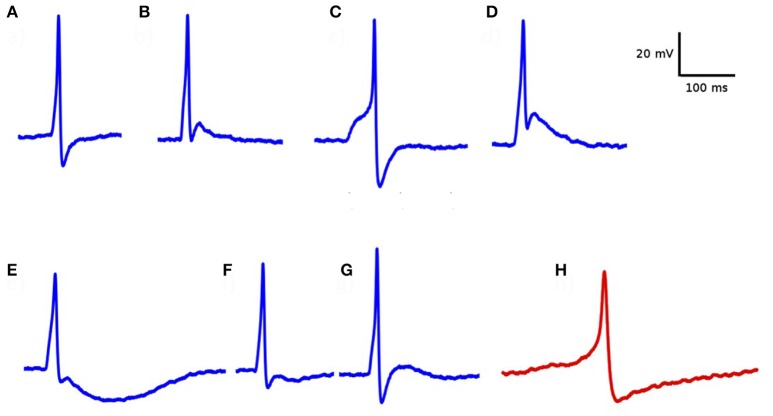
Diversity in action potential shapes observed in detrusor smooth muscle. (A–G) action potentials recorded from a single detrusor smooth muscle cell. All of these have convex-upward feet, indicating that they are of neurogenic origin. (H) An example of “pace-maker” type action potential, given for comparison. Note the ramp-type foot and the lack of after-depolarization. These types of APs are believed to have a myogenic origin.